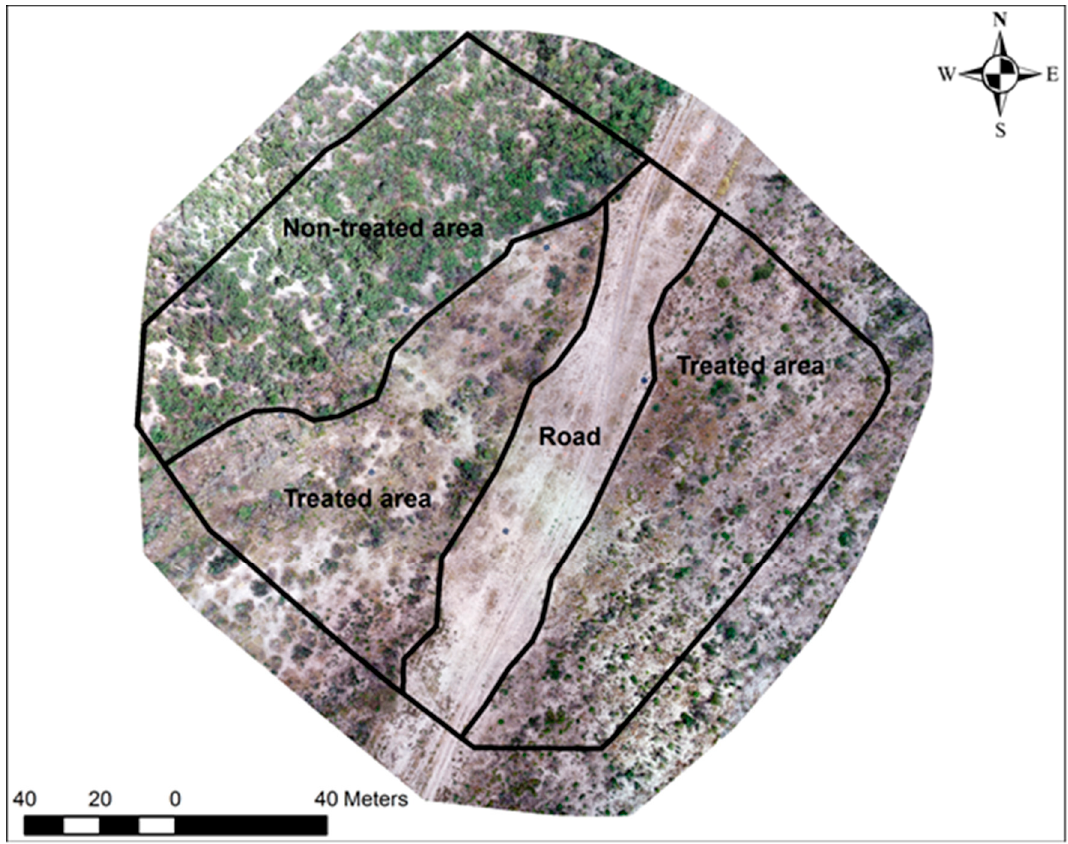
Figure 2. Orthomosaic of the study area obtained at 50 m above ground level on Duval County Ranch in Duval County, TX, 31 August 2018. Black lines represent the boundary between treated areas, non-treated areas, and road.